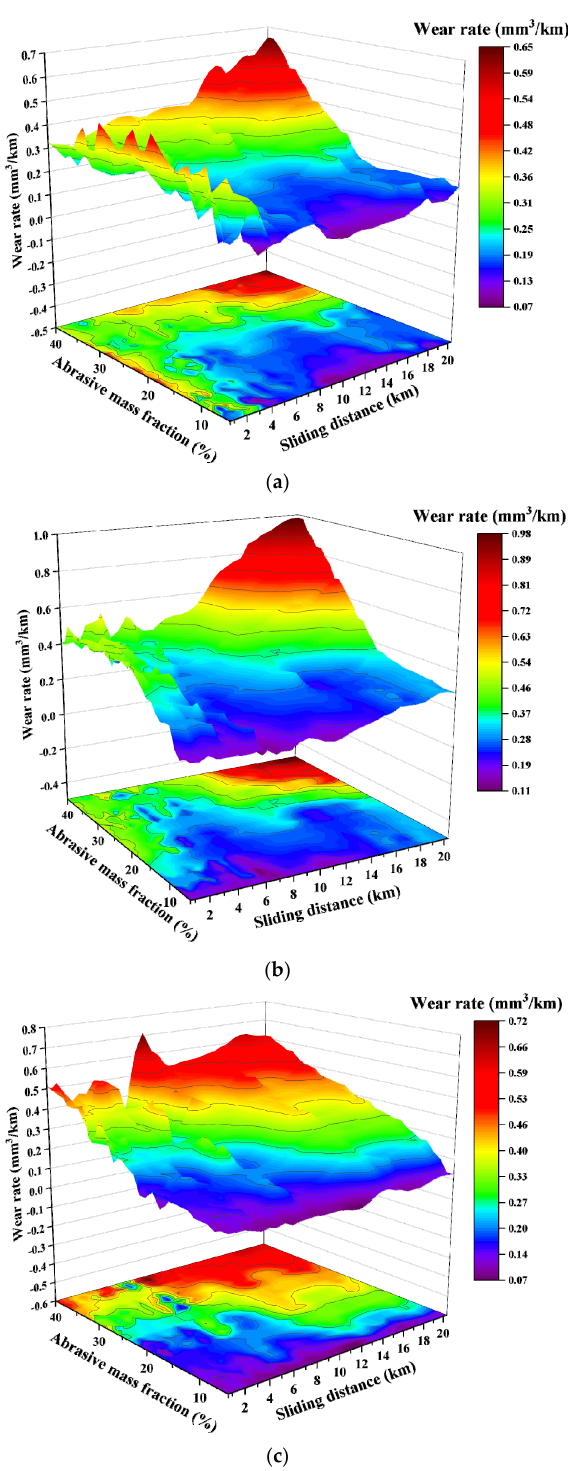
Figure 3. The relationship between the wear rate and the sliding distance for the test groups with mixed abrasives: ( a ) talc and quartz; ( b ) dolomite and quartz; ( c ) fluorite and quartz. However, when a mixture of dolomite and quartz was used the abrasive, the wear rate is relatively stable at the beginning as the sliding distance increases. When the sliding distance exceeds 10 km, the value of the wear rate still increases slightly. But the numerical change of the wear rate becomes very significant when more than 30 wt.% of the abrasive mixture is used. Using a mixture of fluorite and quartz as the abrasive, the value of the wear rate increases slightly, but the overall stability can be kept as the sliding distance increases. 3.3. Morphology and Microstructure of the Abraded Surfaces 3.3.1. Three-Dimensional Morphology by Softer Abrasives Talc has the lowest hardness among the three soft abrasives, and the hardness ratio of 4145H steel to talc ( H/H A ) is 5–6.25 (see Table 2). Figure 4a–c shows the three-dimen- sional surface morphology in the middle area of the specimens after the abrasion tests with slurries containing different mass fractions of talc. The measured surface roughness